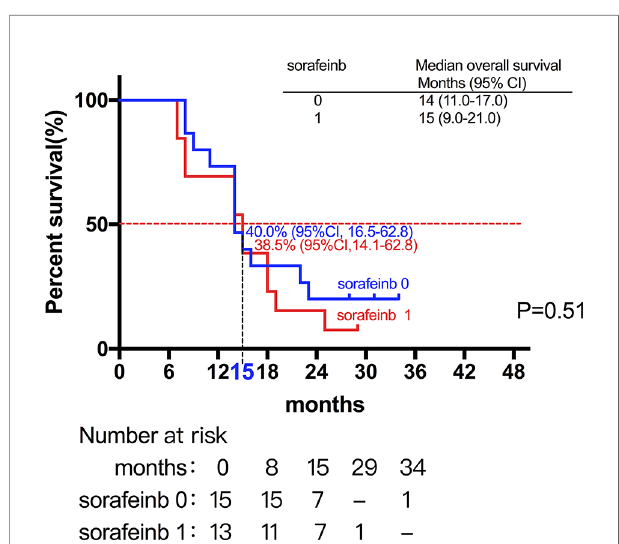
Toxicity: No. of patients